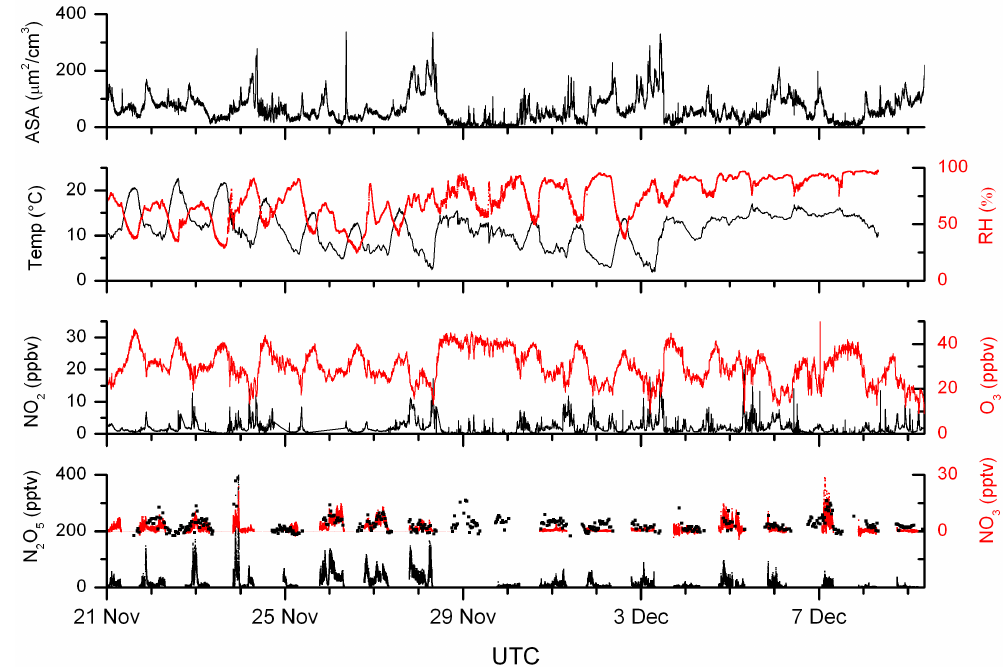
Fig. 2. Campaign overview of measured N 2 O 5 , NO 2 and O 3 mixing ratios, aerosol surface area (ASA), temperature, relative humidity (RH) and calculated CRD-NO 3 mixing ratios (in red). The black NO 3 datapoints are LP-DOAS measurements. x-axis ticks are at midnight.